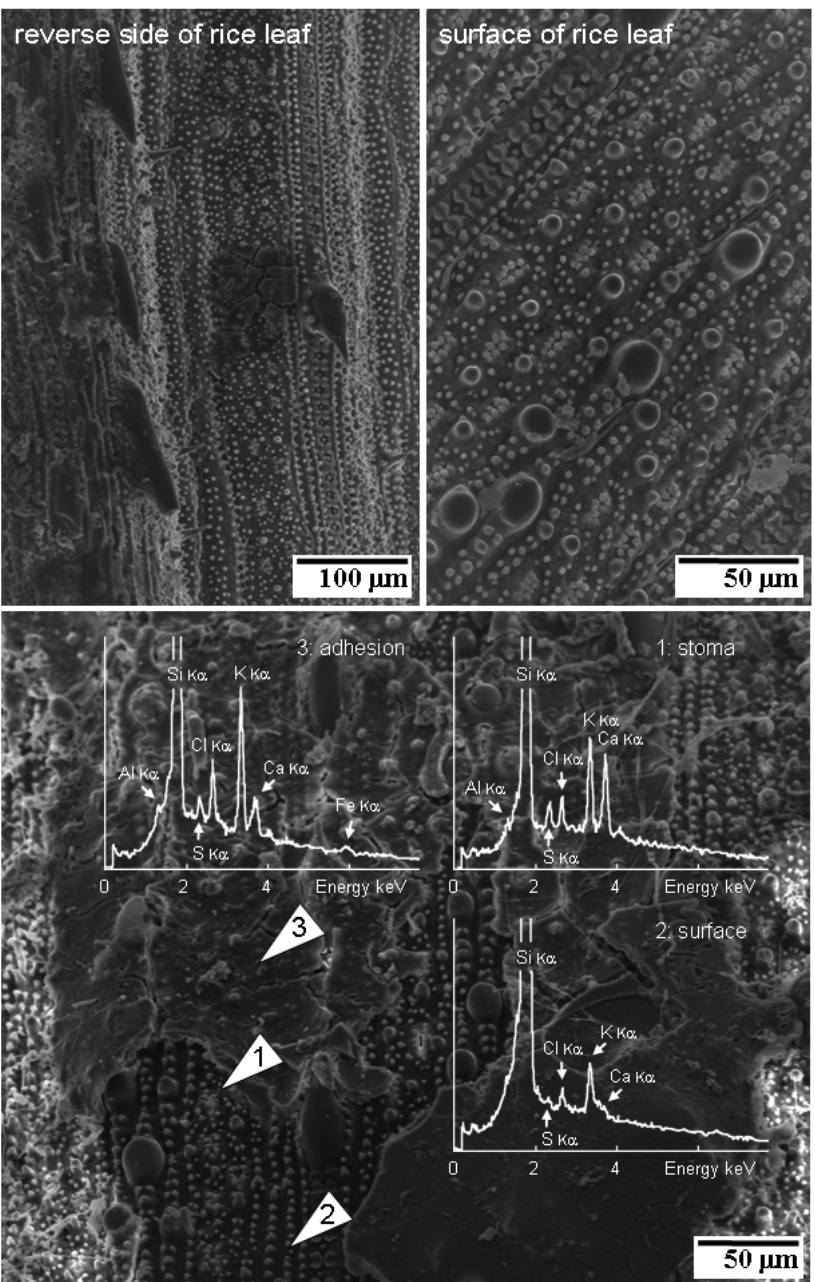
Fig. 7 – Scanning electron microphotographs equipped with energy dispersive analyses (SEM-EDX) of rice leaf collected from landslide areas in Niigata. The stoma, surface, and adhesion area analyses indicated slightly different K/Ca ratio between